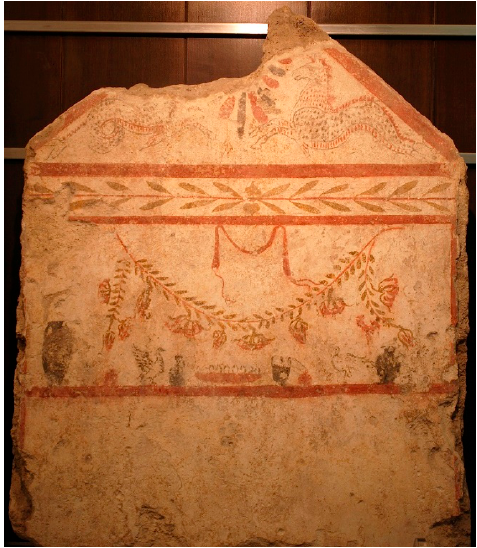
Figure 20. Paestum, Arcioni necropolis: Tomb 271, east slab painted with suspended flower garland over assorted small vases, birds, and a phiale containing eggs (?), ca. 400–375 B.C. Author’s photo.